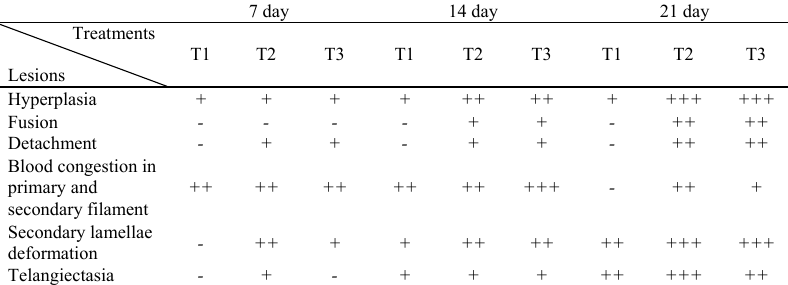
Table1: Histopathological scores of Caspian roach gill exposed to continuous exposure of CuNPs 7 day 14 day 21 day Treatments